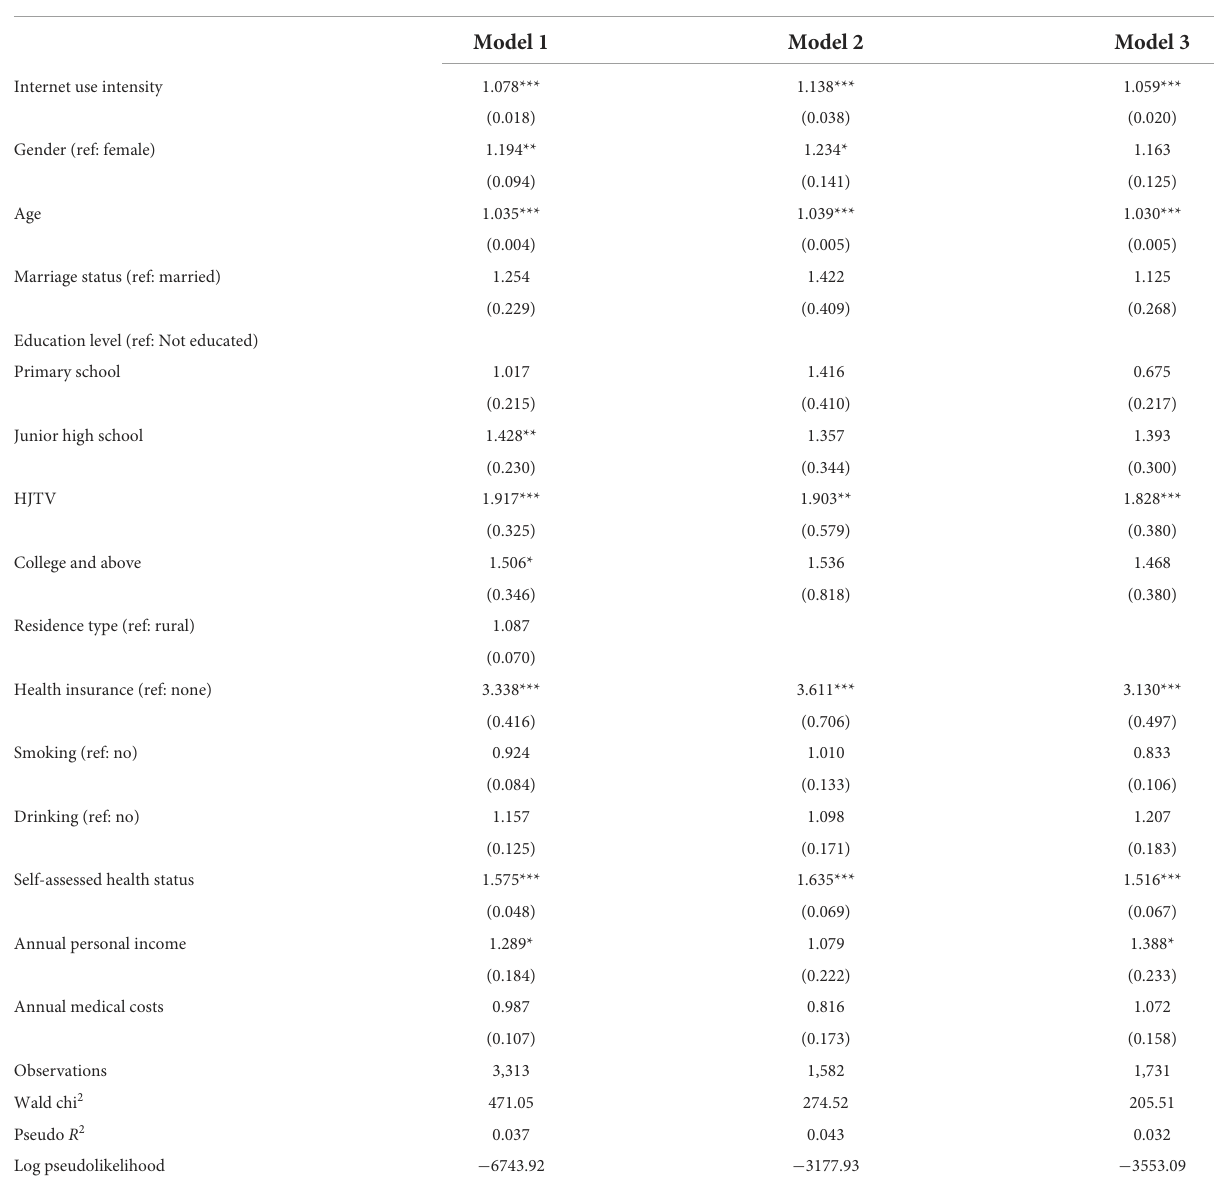
TABLE 3 Results of global and subsample regression analysis ( N =